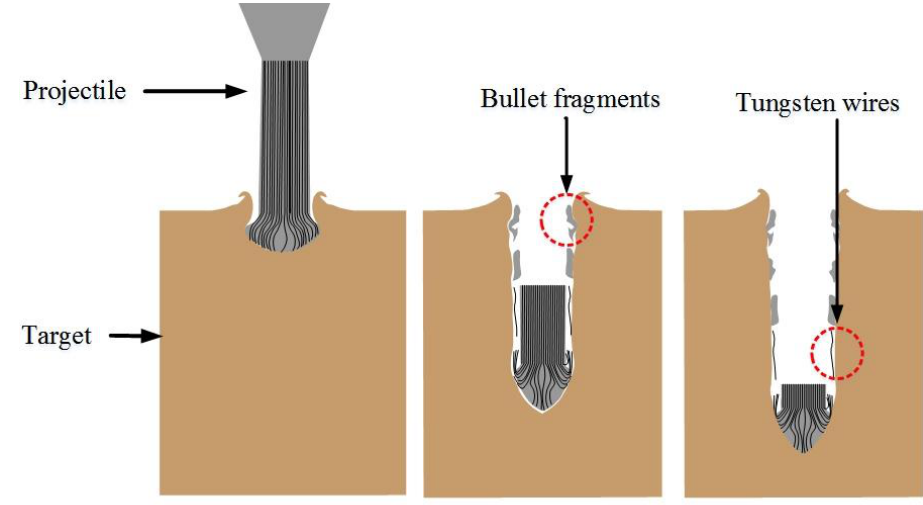
Figure 12. Penetration progress of the RHA by Wf/Zr-MG projectile.